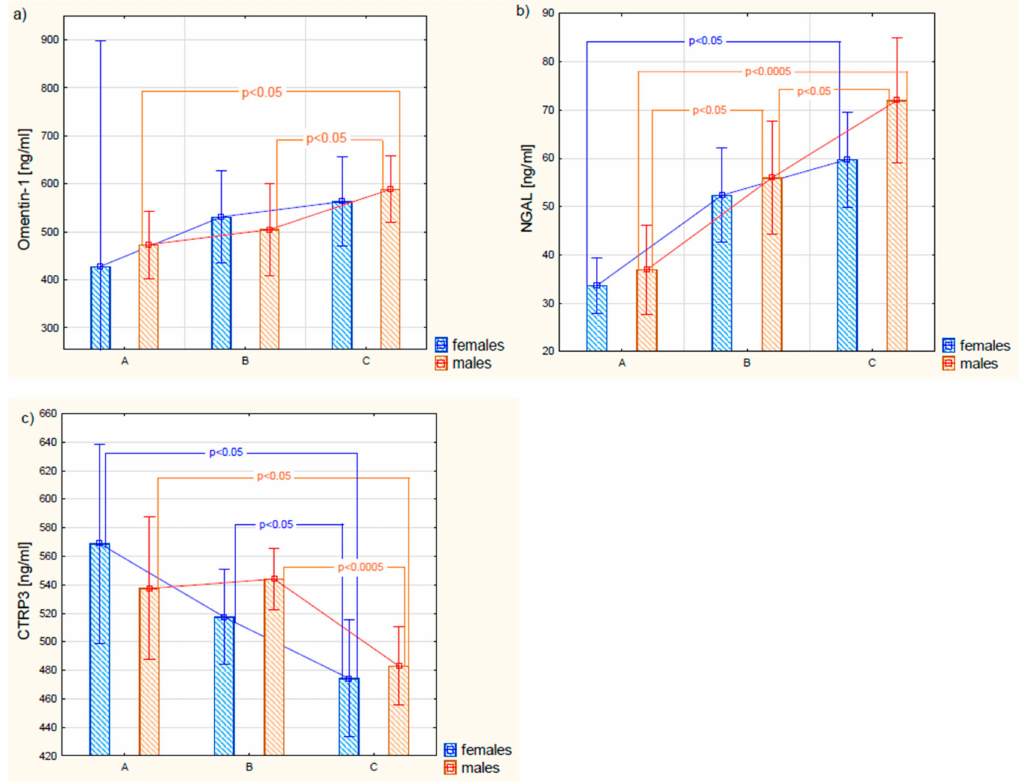
Figure 1. Gender di ff erences in plasma omentin-1 ( a ), NGAL ( b ), and CTRP3 ( c ) levels in control subjects (A), and obese patients with type 2 diabetes before the implementation of insulin therapy (B), and in the same patients after 6-month treatment period (C). The results are expressed as mean ± 0.95 confidence